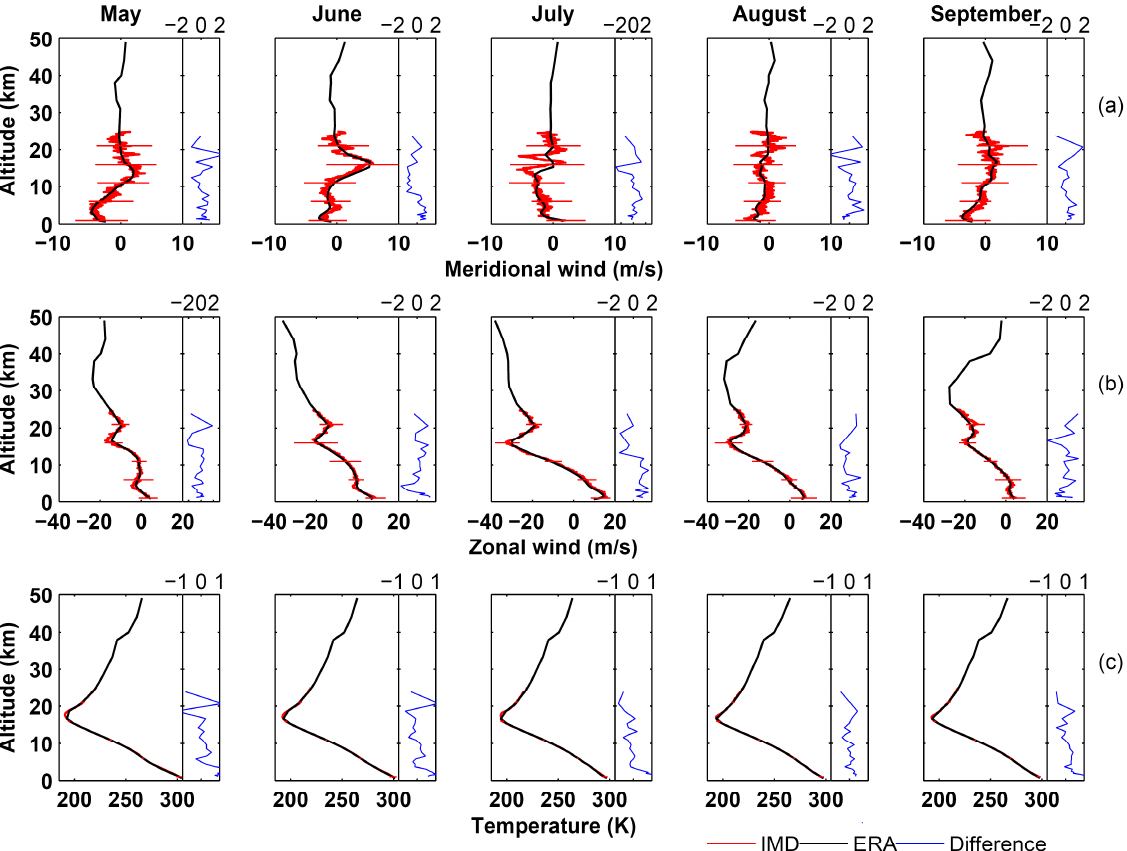
Fig. 1. Mean monthly profiles of meridional (a) , zonal (b) winds and temperature (c) of IMD (red) and ERA (black) with standard deviations at a few heights on measured profiles. The differences between IMD and ERA profiles (blue) are plotted in the right panels of corresponding